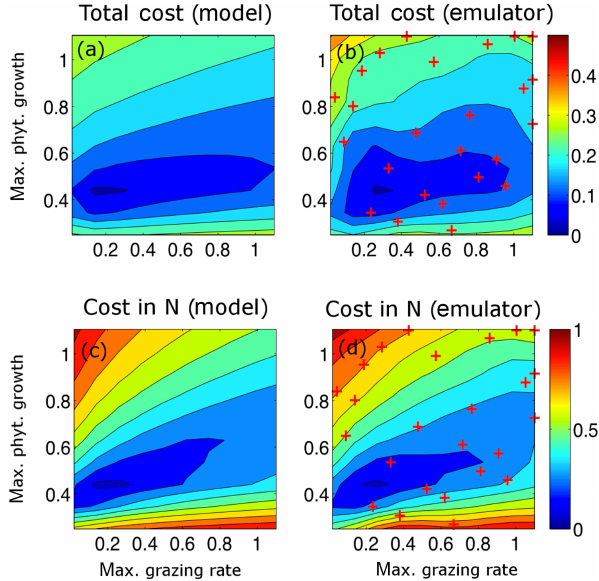
Figure 7. Simulated (a, c) and emulated (b, d) rms (root mean square) error depending on the maximum growth rate of phyto- plankton and the maximum grazing rate. Simulated and emulated rms errors are provided relative to “synthetic observations”, based on a simulation for a given parameter set (HI = 15Wm − 2 ; m = 0.06day − 1 ; µ max = 0.51day − 1 ; H n = 0.8mmolNm − 3 ; m PD = 0.1day − 1 ; m DN = 0.1day − 1 ; H Z = 0.9mmolNm − 6 ; m ZN = 0.01day − 1 ; m ZD = 0.01day − 1 ; g max = 0.21day − 1 ), which is disrupted by reddish noise (AR(3) process) with a standard deviation of 0.09mmolNm − 3 . (Notation after Löptien and Dietze, 2015.) Sub panels (a, b) are based on all prognostic variables, while the rms error in (c, d) is based on nitrate (NO − only (c, d) . Red crosses mark the training